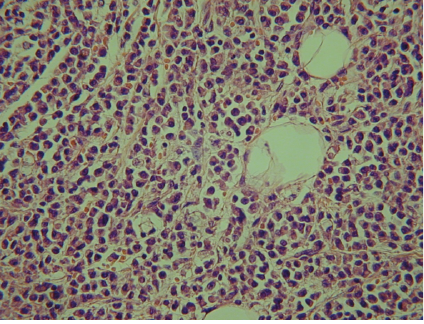
Figure 1: Axial CT image demonstrating primary plasmacytoma of the kidney.